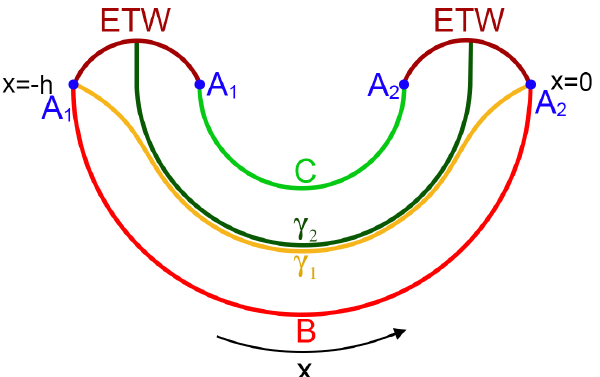
Figure 10 . τ = 0 , ± π slice of the BTZ black hole geometry cut off by ETW branes. The two candidate RT surfaces for region B are depicted. γ